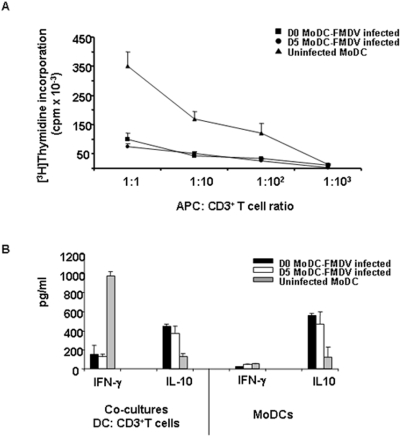
FMDV infection impairs T cell function.A. The allostimulatory capacity of uninfected MoDCs (triangles), FMDV C-S8c1-infected MoDCs at D0 (squares) and FMDV C-S8c1-infected MoDCs at D5 (circles) is indicated at different CD3+ T cells: MoDC ratios. Uninfected or infected MoDCs were irradiated and used as stimulators cells for allogeneic CD3+ T cells. Proliferation was measured in cpm (average cpm±SD) after [3H]Thymidine incorporation and are representative of three independent experiments. B. 72 hours after the onset of the co-cultures MoDCs and CD3+ T cells (ratio 1∶10), or MoDCs, supernatants were collected and analyzed for IFN-γ and IL-10 production by quantitative ELISA. The figure shows mean concentration values (pg/ml). Black bars: FMDV-infected MoDC at D0; white bars: FMDV-infected MoDCs at D5; gray bars: uninfected controls.